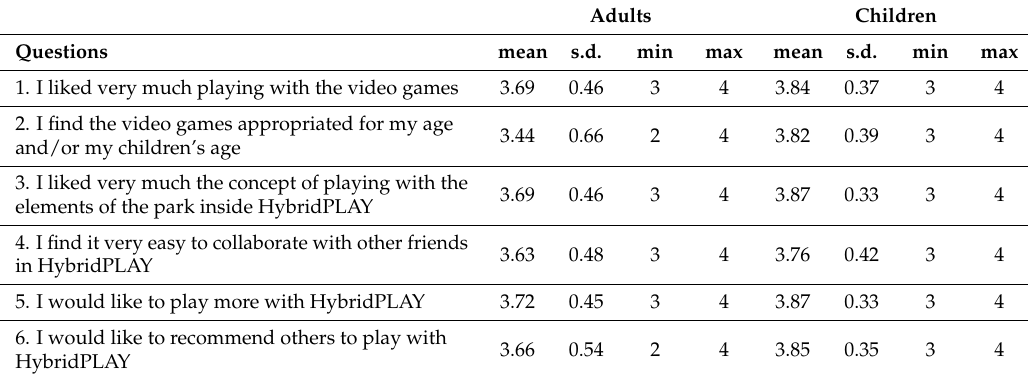
Table 5. Results of the individuals’ satisfaction questionnaires (mean, standard deviation, minimum and